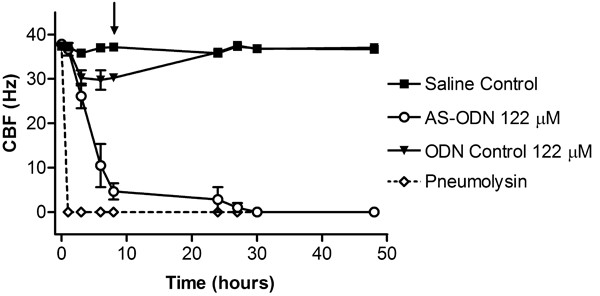
Ciliary beat frequency (CBF) measurements on cultured rat ependymal cells. Ependymal CBF over time in the presence of AS-ODN against Gαi2 (122 μM) and ODN control (122 μM, mismatch oligonucleotide), negative (aCSF) and positive (pneumolysin, 500 HU/ml) controls. The arrow indicates when the aCSF was exchanged for complete growth media. Data are mean ± SEM of n = 4–10. The AS-ODN (122 μM) and pneumolysin (500 HU/ml) graphs were significantly different (p < 0.001) compared to the controls, One-way ANOVA with Tukey's Multiple Comparison test.